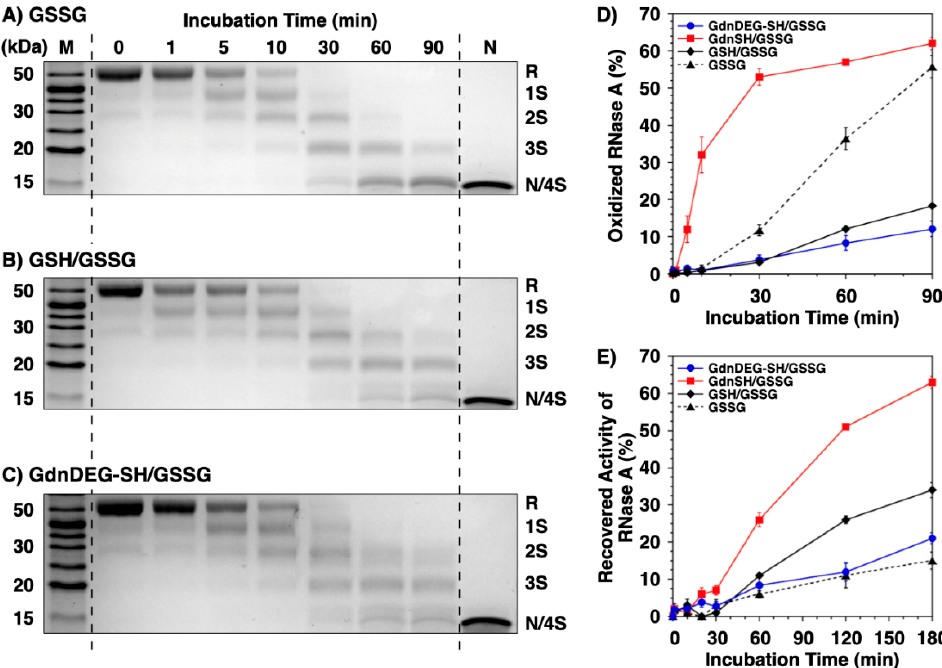
Figure 3. Time course analyses of RNase A oxidation by SDS-PAGE. SDS-PAGE gel images monitoring the oxidation of RNase A (8.0 μ M) in the presence of ( A ) oxidized glutathione (GSSG), ( B ) GSH and GSSG, and ( C ) GdnDEG-SH and GSSG (thiol compounds: 1.0 mM; GSSG: 0.20 mM) in a buffer (50 mM Tris-HCl, 300 mM NaCl, pH 7.5). The oxidation reactions were quenched with maleimide PEG (Mw 2000) after 1, 5, 10, 30, 60, and 90 min incubation. The leftmost and rightmost lanes show the bands corresponding to the markers (M) and native RNase A (N), respectively. R and N/4S represent fully reduced and fully oxidized (a mixture of the native form and a folding intermediate with four disulfide bonds) RNase A, respectively. ( D ) Quantification of the relative band intensities of fully oxidized RNase A (8.0 μ M) to the control (N) in the presence of mixtures of thiol (1.0 mM) and disulfide compounds (0.20 mM; blue filled circles: GdnDEG-SH/GSSG, red filled squares: GdnSH/GSSG [17], black filled diamonds: GSH/GSSG, and black filled triangles: GSSG only) quantified from SDS-PAGE analyses. ( E ) Recovered enzymatic activity of RNase A (8.0 μ M) during incubation in the GdnDEG-SH/GSSG (blue filled circles), GdnSH/GSSG (black filled diamonds) [17], GSH/GSSG (black filled diamonds), and GSSG only (black filled triangles) systems (thiol compounds: 1.0 mM; disulfide compounds: 0.20 mM) in a buffer (50 mM Tris-HCl, 300 mM NaCl, pH 7.5). The activity was evaluated by spectroscopic monitoring of the hydrolysis of cytidine 2 ′ :3 ′ -cyclic monophosphate (cCMP) to 3 ′ -CMP at 30 °C. Error bars indicate the means ± SEM of three independent experiments.